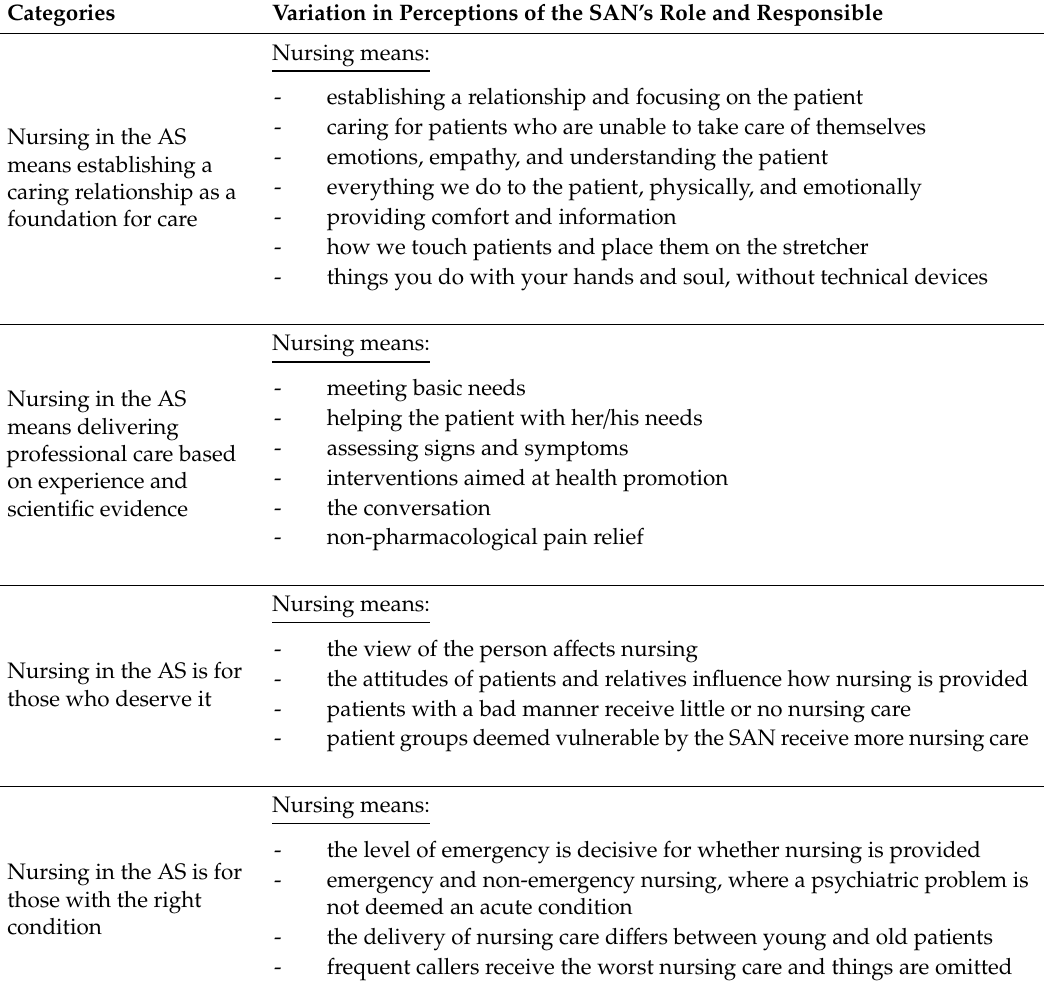
Table 2. The SANs’ perceptions of what nursing means and how it a ff ects their perception of their role and